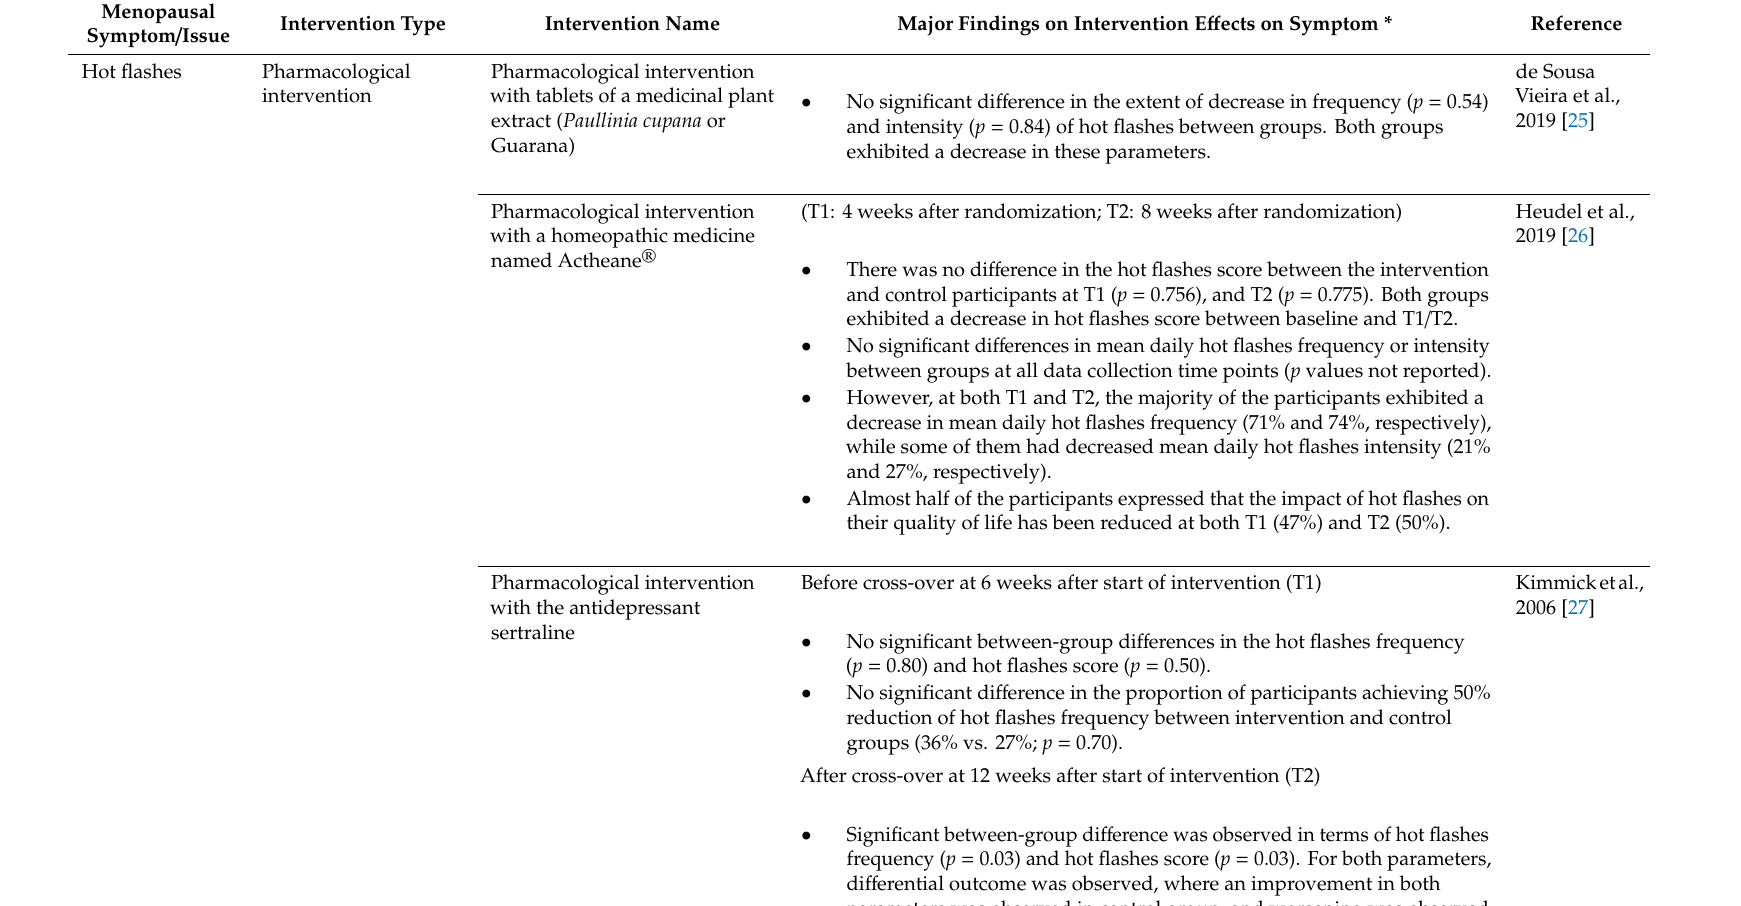
Table 4. A summary of the e ff ects of reported interventions on individual adjuvant endocrine therapy-induced menopausal symptoms and sexual issues. Menopausal Symptom /